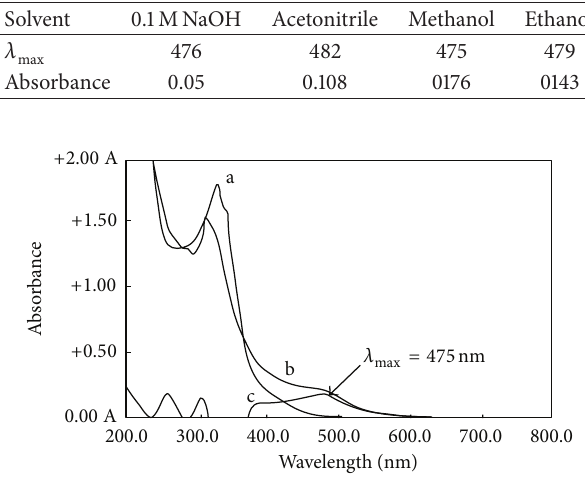
Figure 2: UV-VIS absorption spectra of (a) MNDTT, (b) Cu- MNDTT complex, and (c) Cu-MNDTT complex against reagent blank ( 𝜆 max = 475 nm).